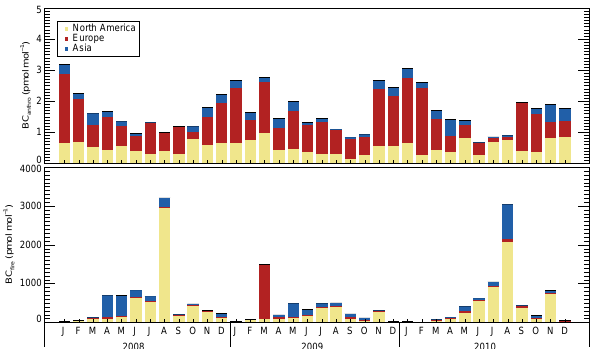
Figure 6. Bar chart showing the total monthly BC anthro (top) and BC fire (bottom) tracer from FLEXPART for 2008, 2009, and 2010. The different colours represent the contributions from North Amer- ica, Europe, and Asia as shown in the